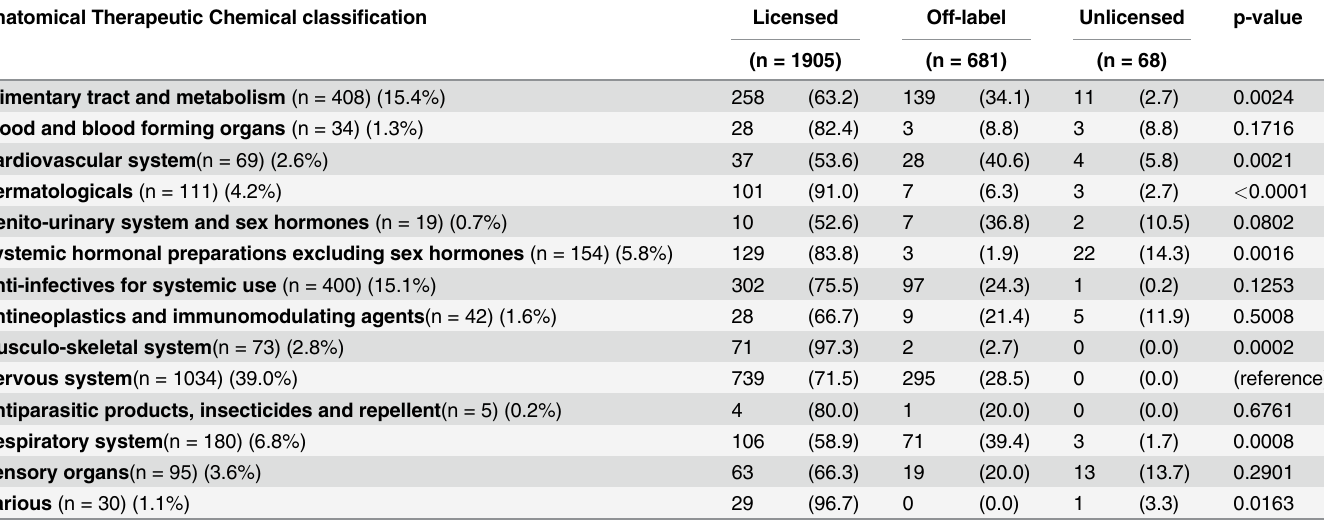
Table 4. Frequency (percentage) of licensed, off-label and unlicensed drugs prescribed in each Anatomical Therapeutic Chemical classi fi cation (ATC) category. Anatomical Therapeutic Chemical classi fi